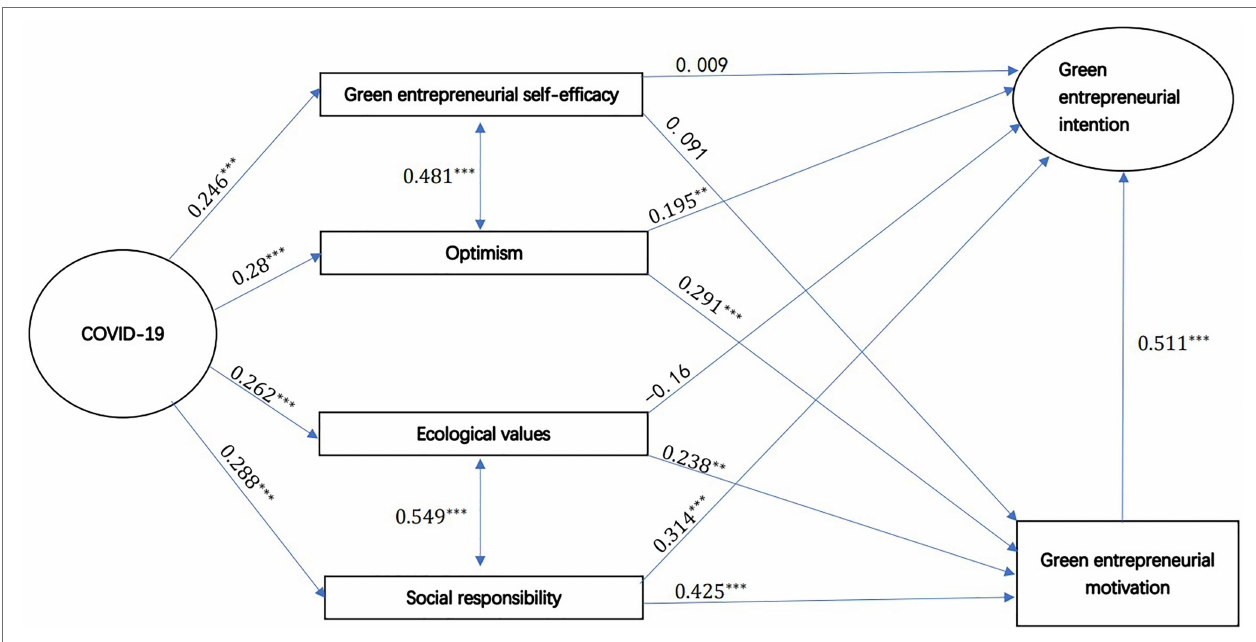
FIGURE 3 | Structure model.